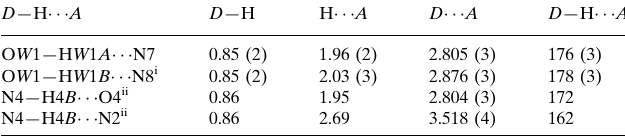
Hydrogen-bond geometry (A˚ , (cid:3)